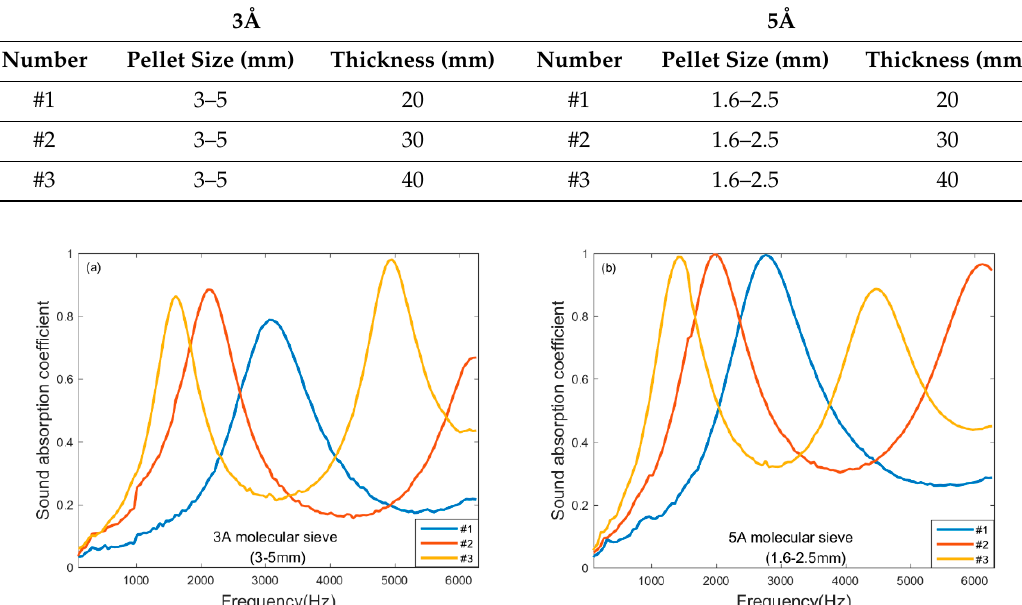
Table 2. Samples of molecular sieve pellets with different layer thickness.